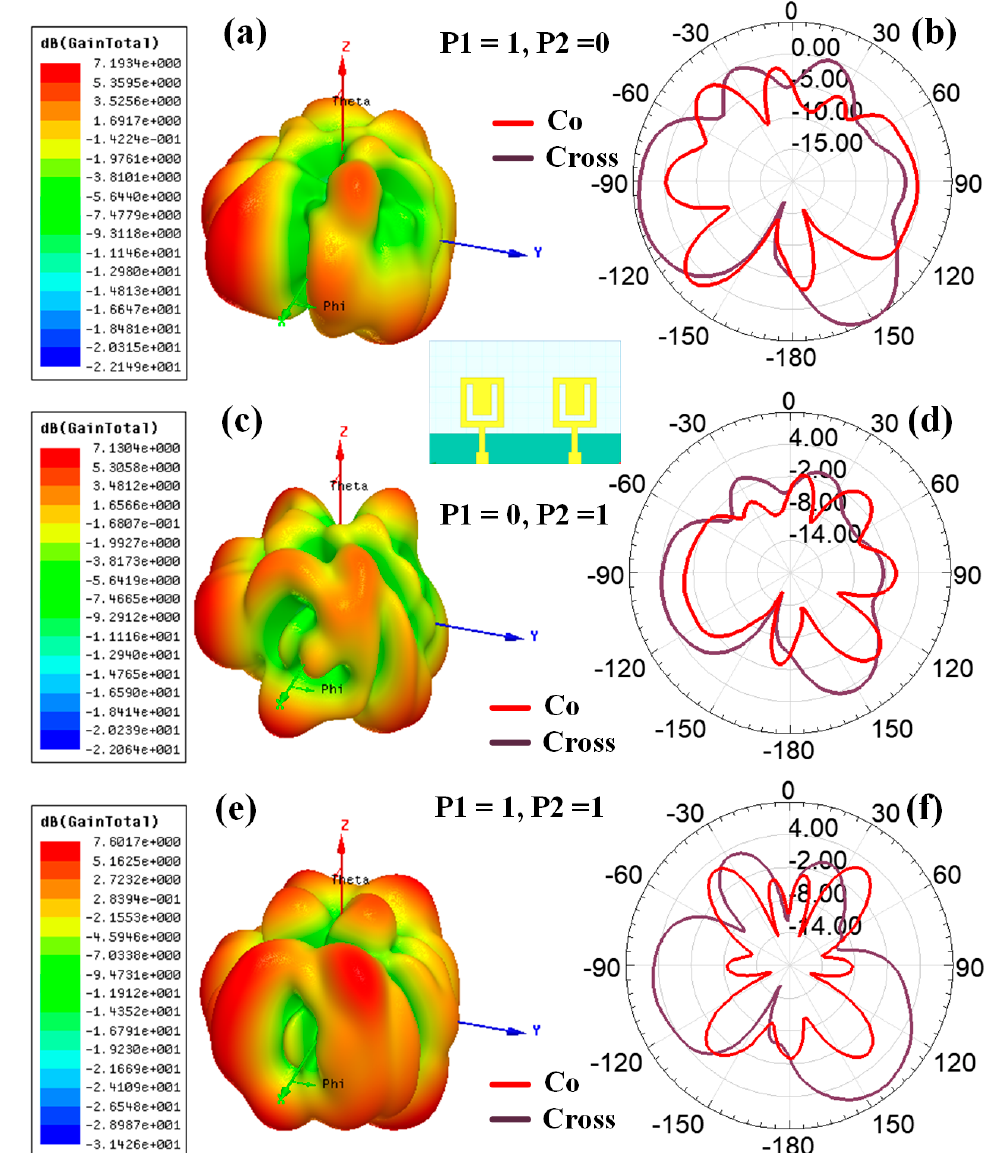
Figure 10. Variation in the polar plot for the different port excitation conditions (Design 3) (simulated results). The 3D polar plot for the ( a ) (P1, P2) = (1, 0), ( c ) (P1, P2) = (0, 1), and ( e ) (P1, P2) = (1, 1). 2D polar plot for the ( b ) (P1, P2) = (1, 0), ( d ) (P1, P2) = (0, 1), and ( f ) (P1, P2) = (1, 1), with co-polar and cross-polar conditions.